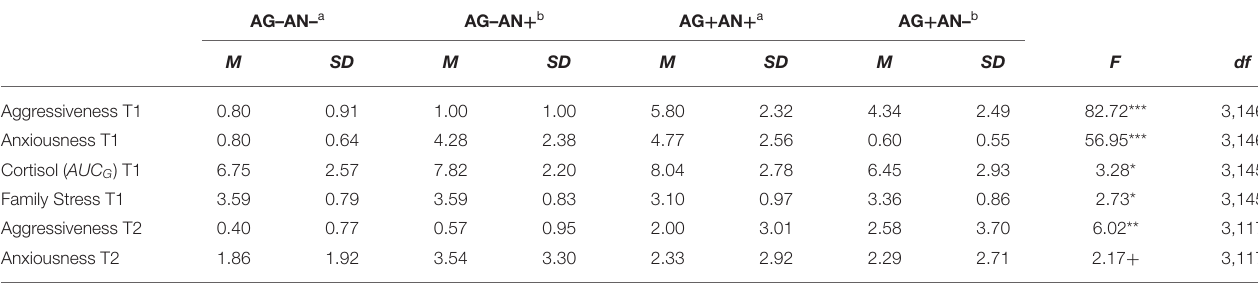
TABLE 2 | Means (M) and standard deviations (SD) of the four groups in study variables. AG–AN–